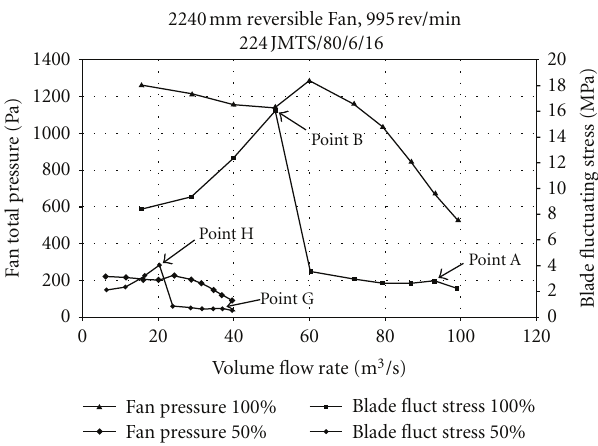
Figure 5: Stall characteristics of the test fan with a stalling blade stagger angle at full and half speed.